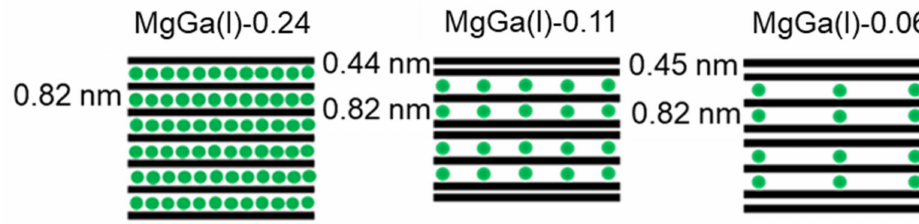
Figure 1. ( A ) XRD patterns of MgGa(I)-x (x = 0.24 (a), 0.18 (b), 0.11 (c), 0.10 (d), 0.08 (e), and 0.06 (f)). ( B ) Relation between the lattice parameter a and the x value in the MgGa–LDHs.